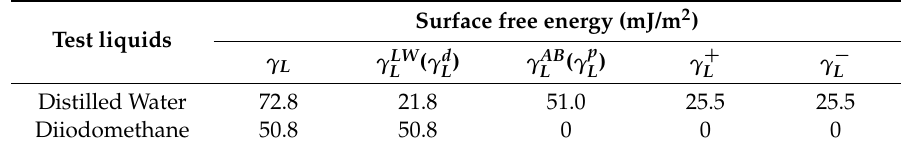
Table 2. Surface Tension and Components of the Test Liquids